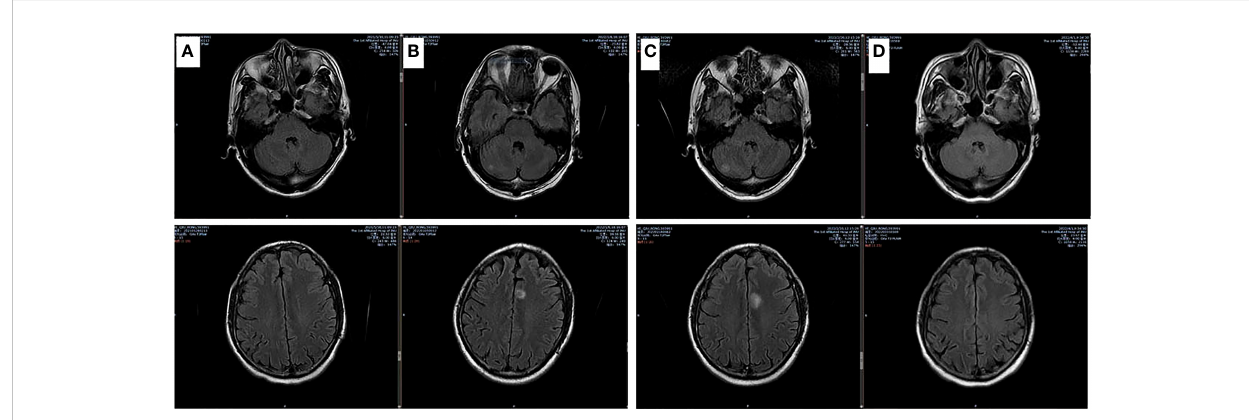
FIGURE 2 Brain MRI images of involved matastasis images. (A) Base line; (B) After chemotherapy for 5 cycles and lung radiation for 25 cycles; (C) 1 month after newly BMs; (D) 1 month after brain radiation and anlotinib